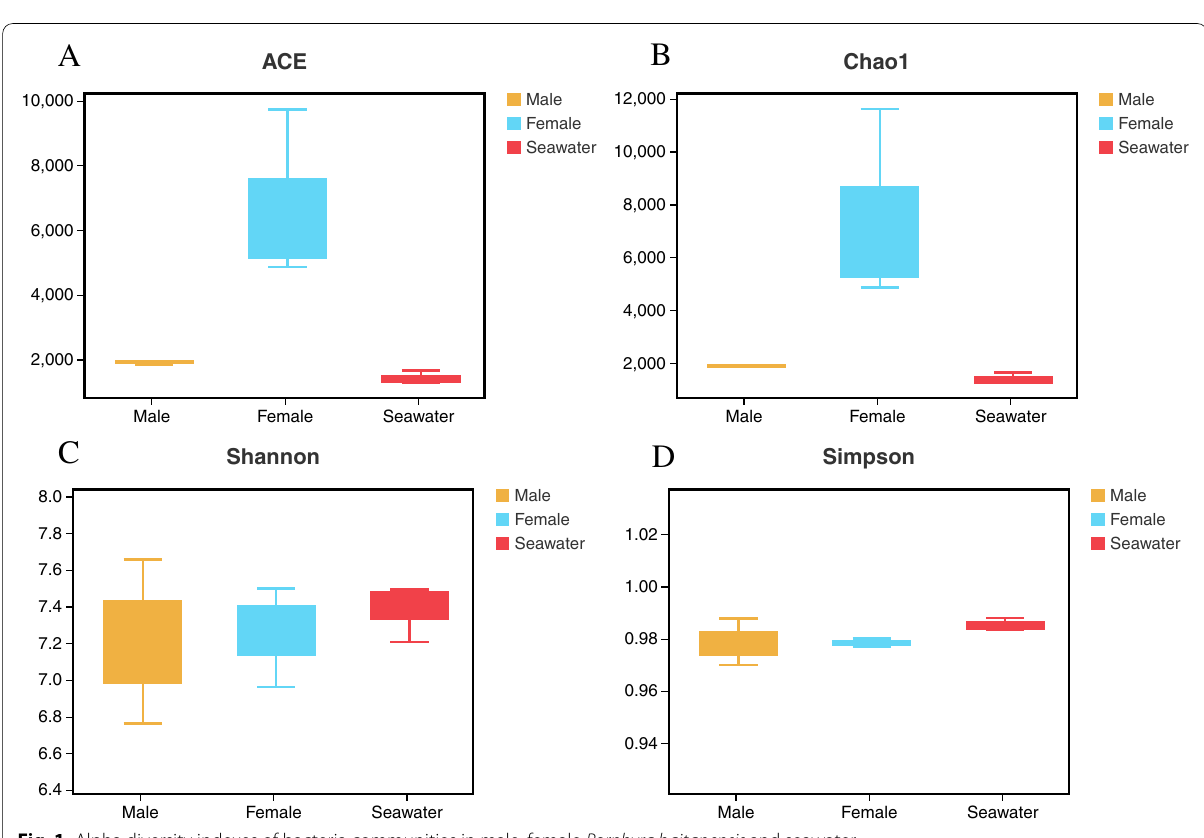
Fig. 1 Alpha diversity indexes of bacteria communities in male, female Porphyra haitanensis and seawater